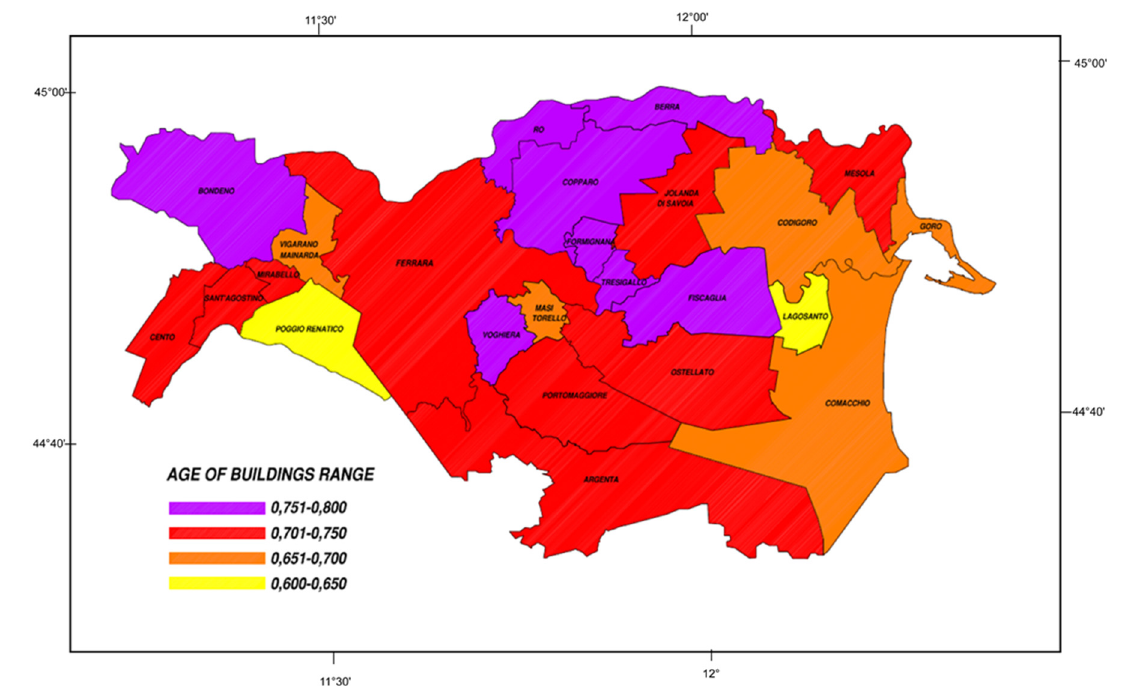
Figure 8. Map of the vulnerability parameter for the province of Ferrara computed as a function of the building age.